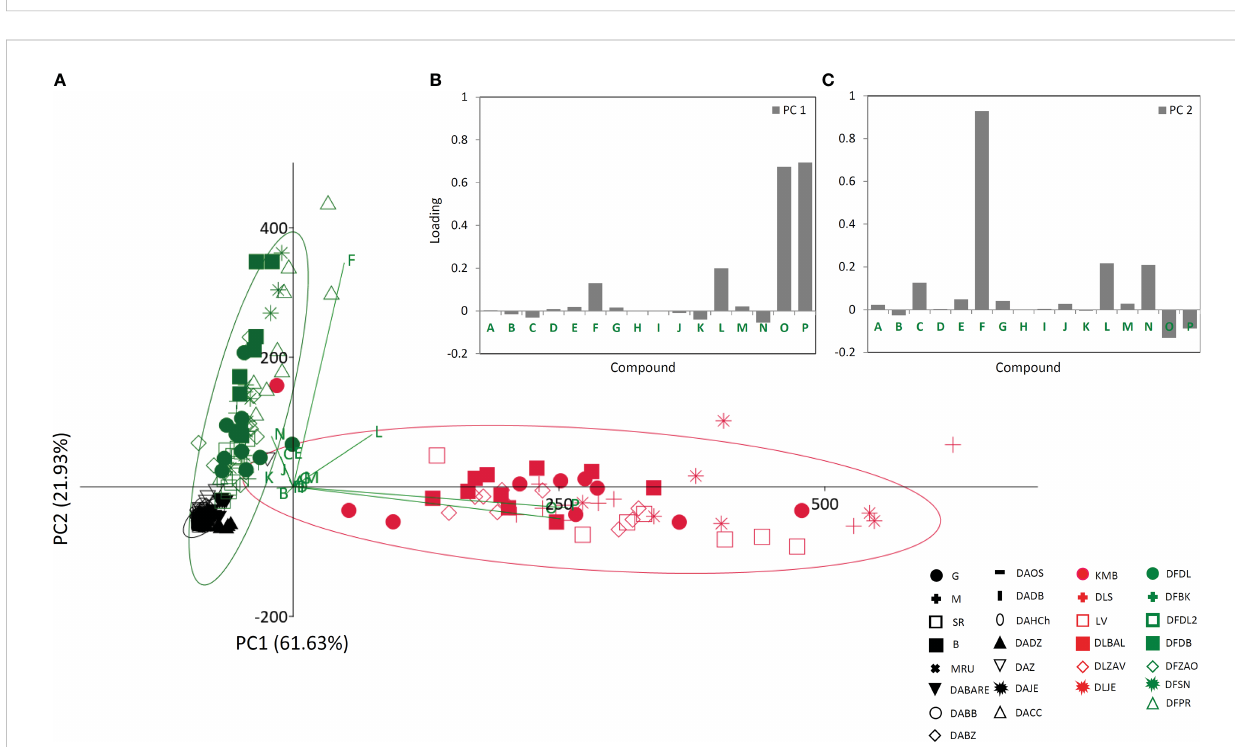
FIGURE 3 Principal component analysis (PCA) biplot with the fi rst two PCs explaining 83.56% of total variance (A) . For each species 95% con fi dence ellipses are presented: black − Digitalis grandi fl or a, red − D. lanata , green − D. ferruginea . Different symbols indicate af fi liation of populations. Participation of the variables in the fi rst two PCs is indicated by the corresponding vectors and by loading plots presented separately for PC1 (B) and PC2 (C) . Variables protocatechuic acid , A; syringic acid, B; p -hydroxybenzoic acid, C; 5- O -caffeoylquinic acid, D; caffeic acid, E; p -coumaric acid, F; aesculetin, G; isoorientin, H; quercetin-3- O -glucoside, I; naringin, J; luteolin, K; hispidulin, L; isorhamnetin, M; digoxin, N; deslanoside, O; lanatoside C, P. For the interpretation of population abbreviations in the fi gure legend, please refer to Table